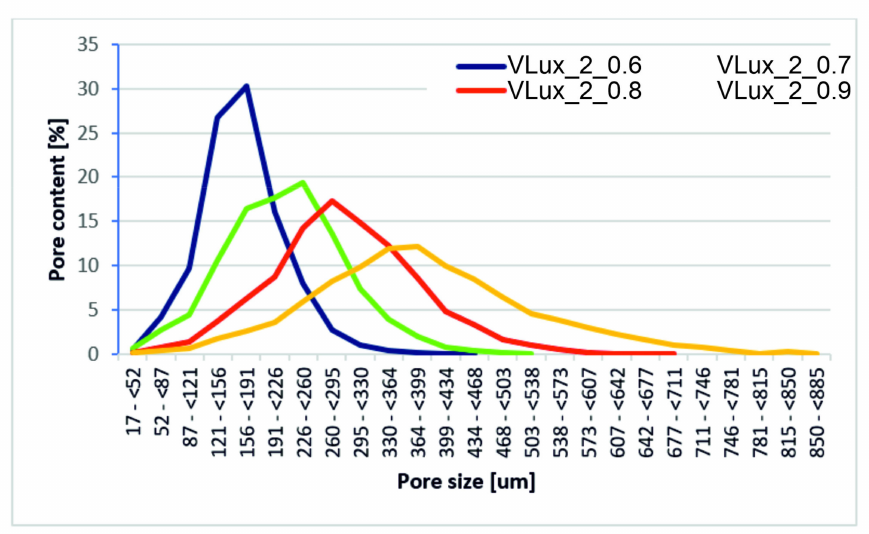
Figure 10. The results of the pore size analysis of foams with different INCO containing 2 php of water were obtained during the analysis using µ